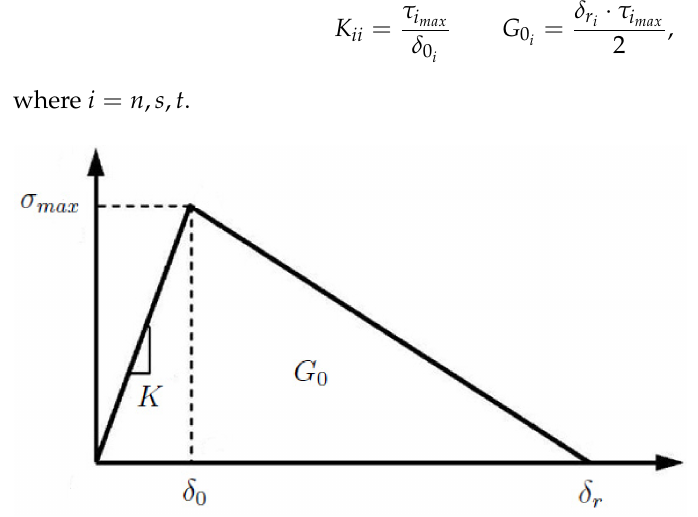
Figure 1. Traction Separation Law considered. The cohesive strength σ max , the initial (reversible) interface displacement δ 0 and the maximum cohesive displacement, δ r , are parameters to be